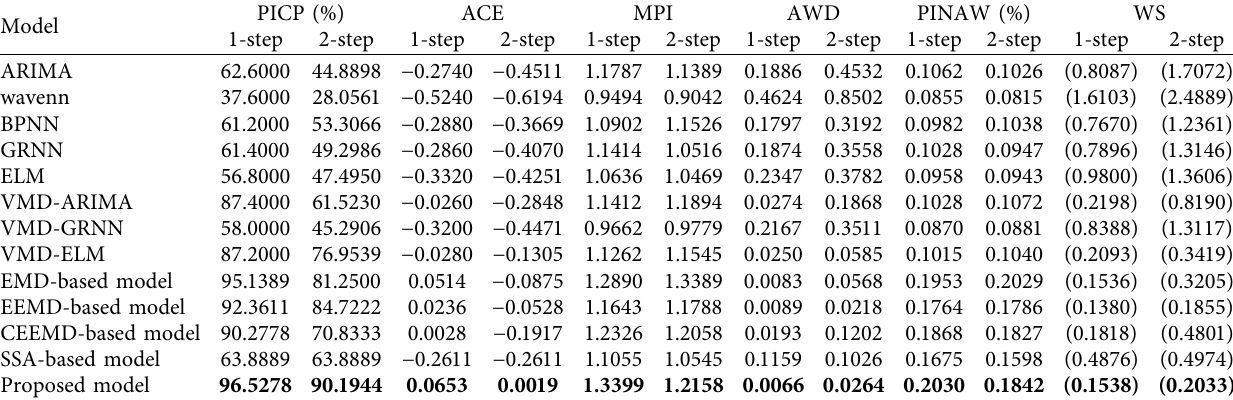
Table 7: Performances of the designed model compared with all other models for site